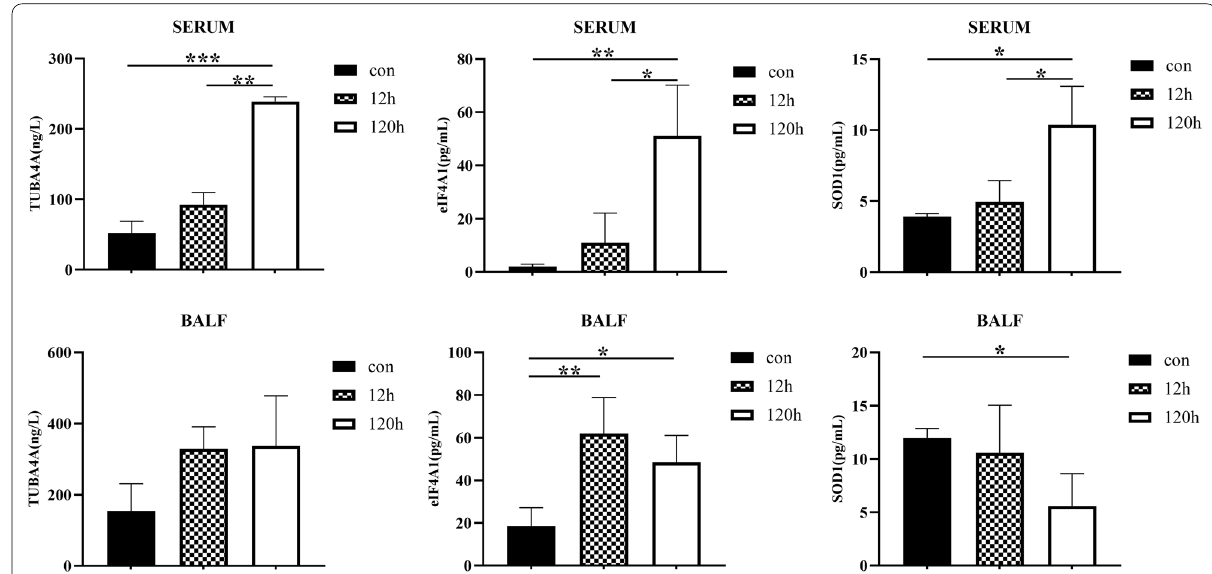
Fig. 7 ELISA analysis of proteins of interest in BALF and serum. TUBA4A, SOD1 and EIF4A proteins in serum and BALF samples were analyzed by ELISA at 12 h and 120 h post infection. The level of TUBA4A, SOD1 and EIF4A in BALF were consistent with the results of omics analysis (12h/0h and 120h/12h). The level trends of TUBA4A, SOD1 and EIF4A in serum were also consistent with the omics data only at 12 h, no difference or increase trend at 120h/12 h in serum. “*” represents p < 0.05, “**” p < 0.01, “***” p <